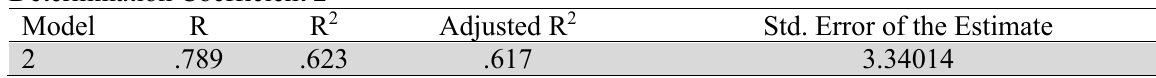
Determination Coefficient 2